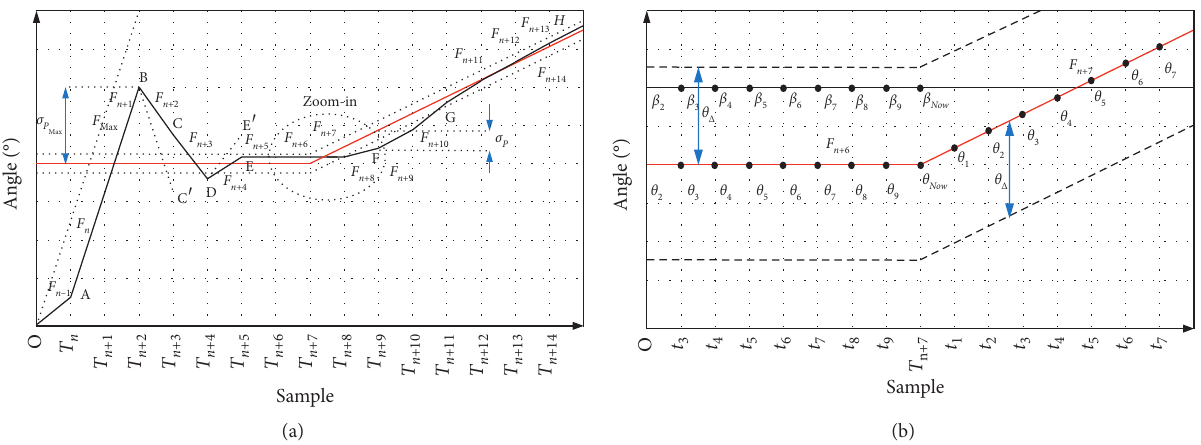
Figure 19: Identification tracking control method. (a) Identification control method. (b) Target and tracking value